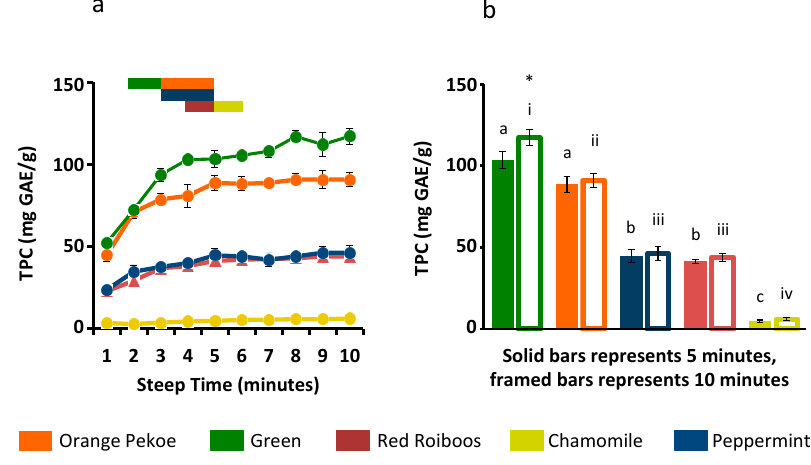
Figure 2. The effect of steep time on TPC of five different types of teabags. ( a ) measured TPC/g at steep times of 1–10 min. Coloured bars indicate the manufacturers suggested steep time for each tea type; ( b ) The TPC/g of tea after a steep time of 5 min (solid coloured bars) compared to 10 min (framed bars). n = 6/sample (excluding time point 1 min for chamomile which had n = 3/sample), error bars are ±SEM, GAE = Gallic acid equivalents. * represents a significant difference between 5 and 10 min for Green tea ( p < 0.05). Between tea comparisons were made separately for 5 min (letters) and 10 min (Roman numerals) data ( p < 0.05). Specifically, TPC at 5 min significantly differs among tea types that have different letters while TPC at 10 min significantly differs among tea types that have different Roman numerals.